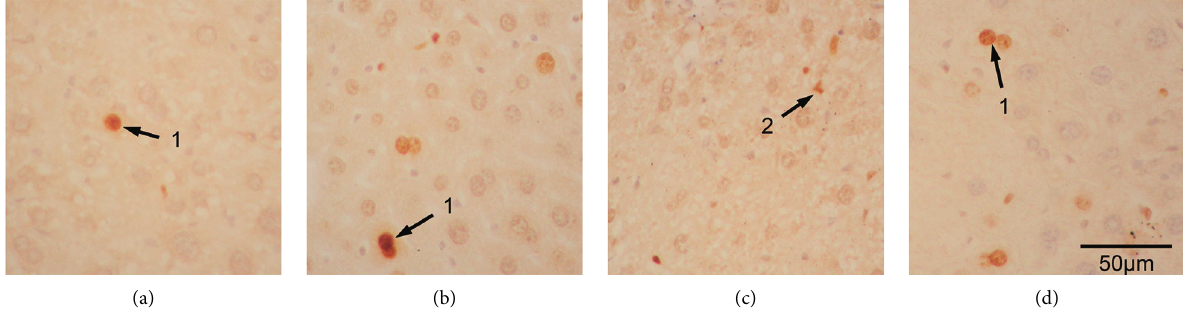
Figure 6: PCNA-positive nuclei in the saline- (a), ethanol- (b), fluoxetine- (c), and atorvastatin-treated (d) liver. Arrows denote positive cells; 1 denotes a positive liver cell nucleus; and 2 denotes a Kupffer cell nucleus, 400X.